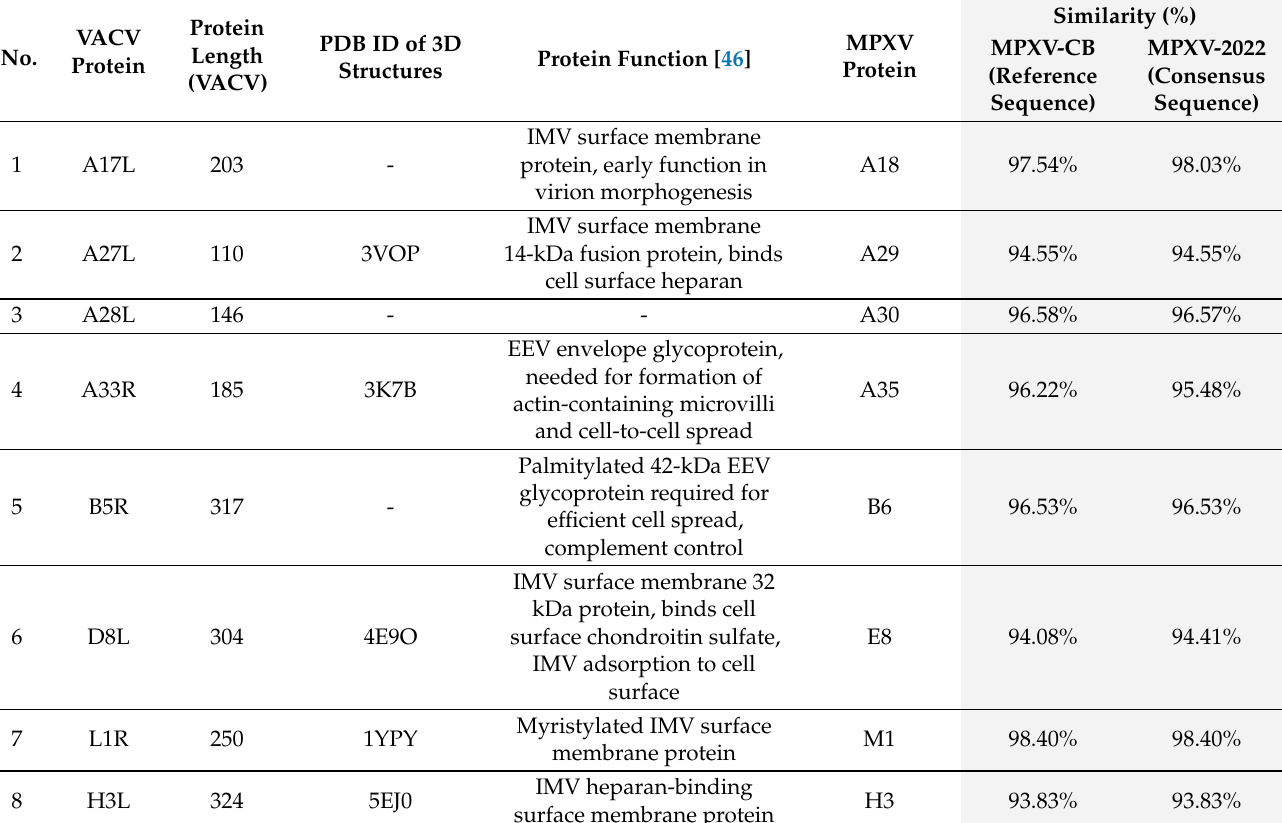
Table 1. Summary of the VACV proteins known to be targets of